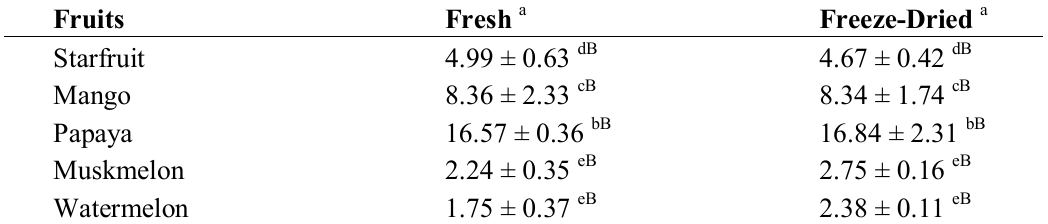
Table 3. Ascorbic acid content of fresh and freeze-dried fruits.